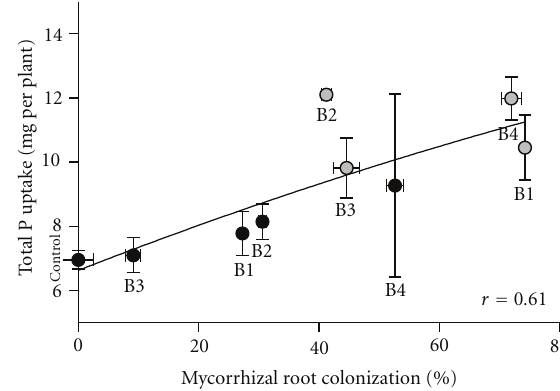
Figure 6: Non-linear regression analysis showing a significant pos- itive correlation ( P < . 01) between total P-content in wheat plants and mycorrhizal fungal root colonization, in combination with all P. polymyxa strains (B1–B4) at harvest (15 weeks). The untreated control without added microorganisms (no AMF colonization) is included. Other treatments were omitted as they did not signifi- cantly a ff ect total P-content. Black circles represent strains added at a concentration of 10 6 bacterial cells 10g − 1 of seeds, whereas grey circles correspond to added amounts of 10 8 bacterial cells 10g − 1 of seeds. Error bars represent the standard error of the